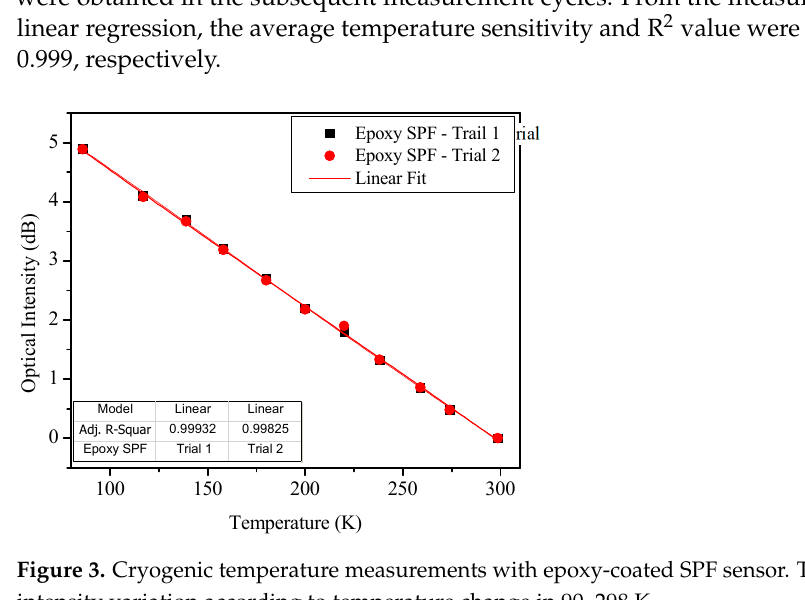
4 of 7 Figure 2. Experimental setup of the proposed fiber-optic sensor system. SM—single mode; SPF— side-polished fiber; PD—photo detector; DAQ—data acquisition; ASE BBS—amplified spontaneous emission broadband source. The fabricated epoxy-coated SPF was placed in a temperature chamber, and the tem-